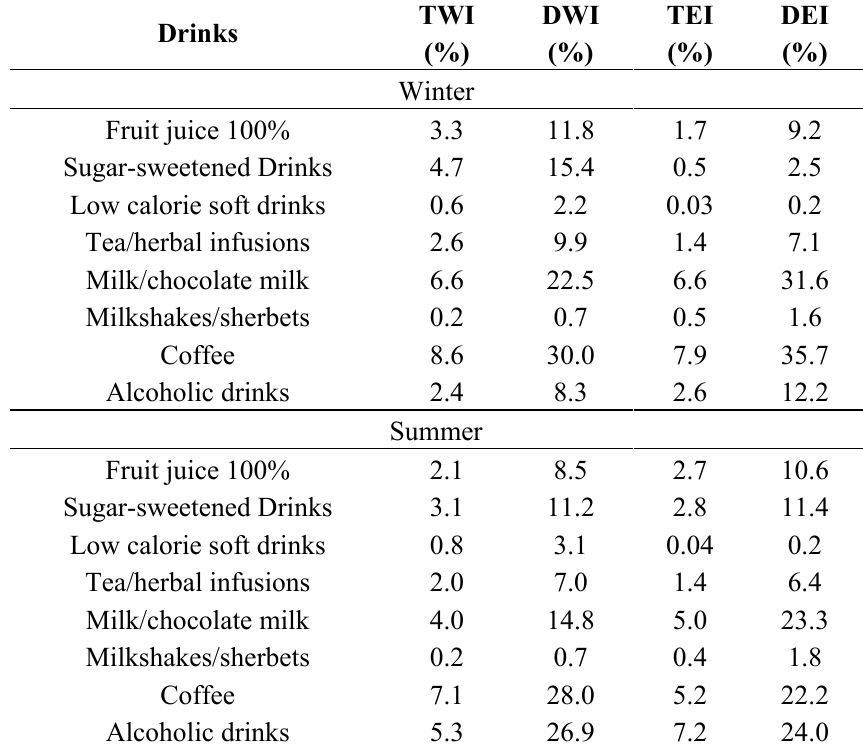
Table 4. Contribution of drinks in total water intake (TWI), total energy intake (TEI), drink water intake (DWI) and drink energy intake (DEI) during winter and